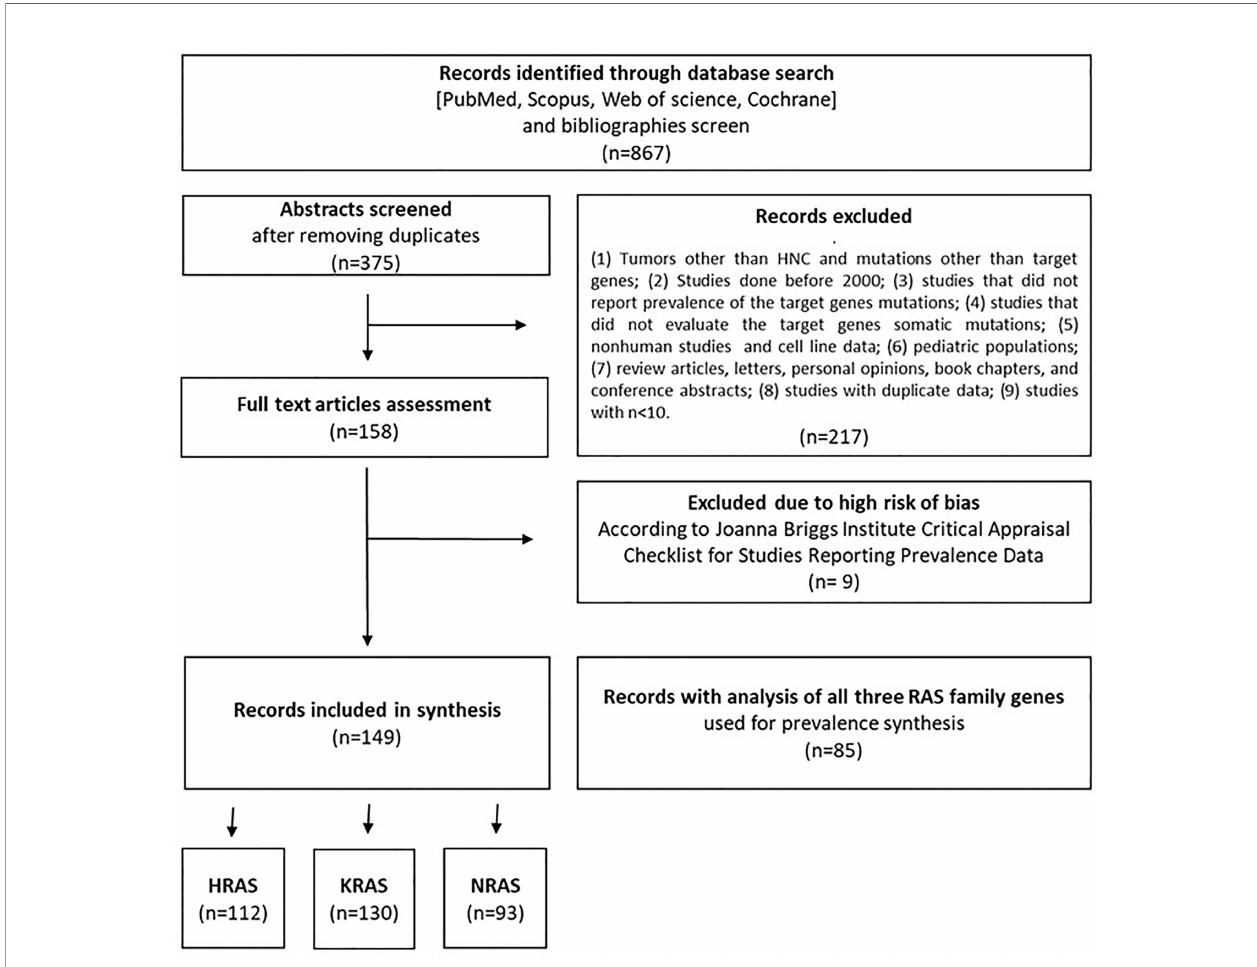
FIGURE 1 | Flow diagram of the literature search process and selection